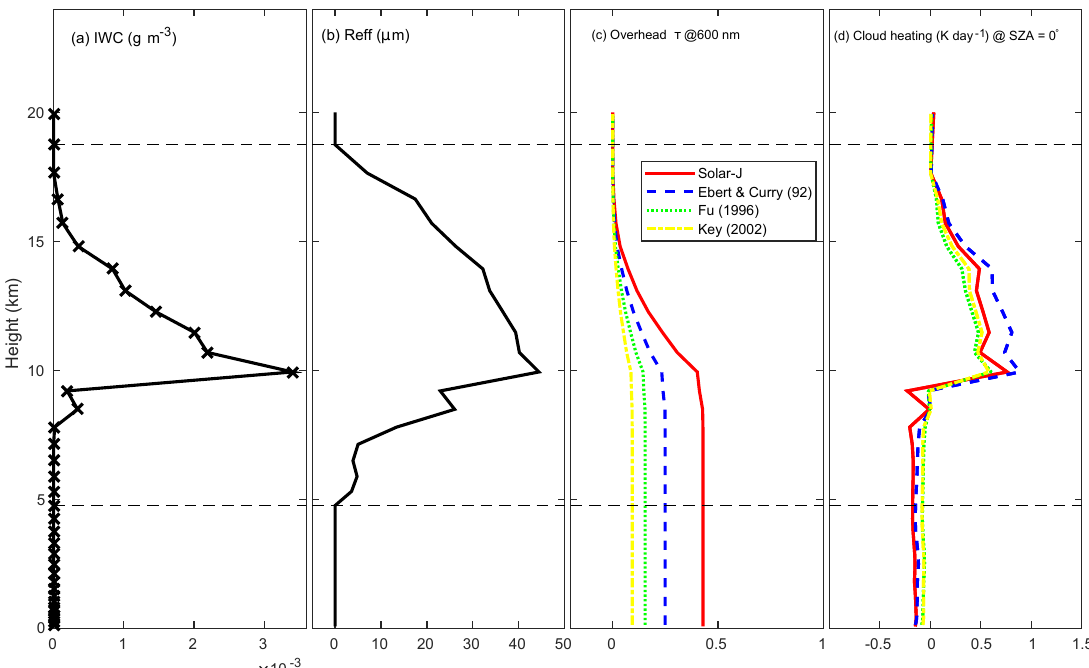
Figure 5. (a) Profiles of ice-water content (IWC, gm − 3 ) and (b) effective radius ( r e , µm) as prescribed for both Solar-J and RRTMG-SW. The in-cloud region, about 4–18km, is enclosed by two horizontal dashed lines. (c) Profiles of cumulative optical depth τ at 600nm from Solar-J and from the three RRTMG-SW parameterizations for which τ is delta scaled. (d) Cirrus cloud heating rate profiles (Kday − 1 ) at an SZA of 0 ◦